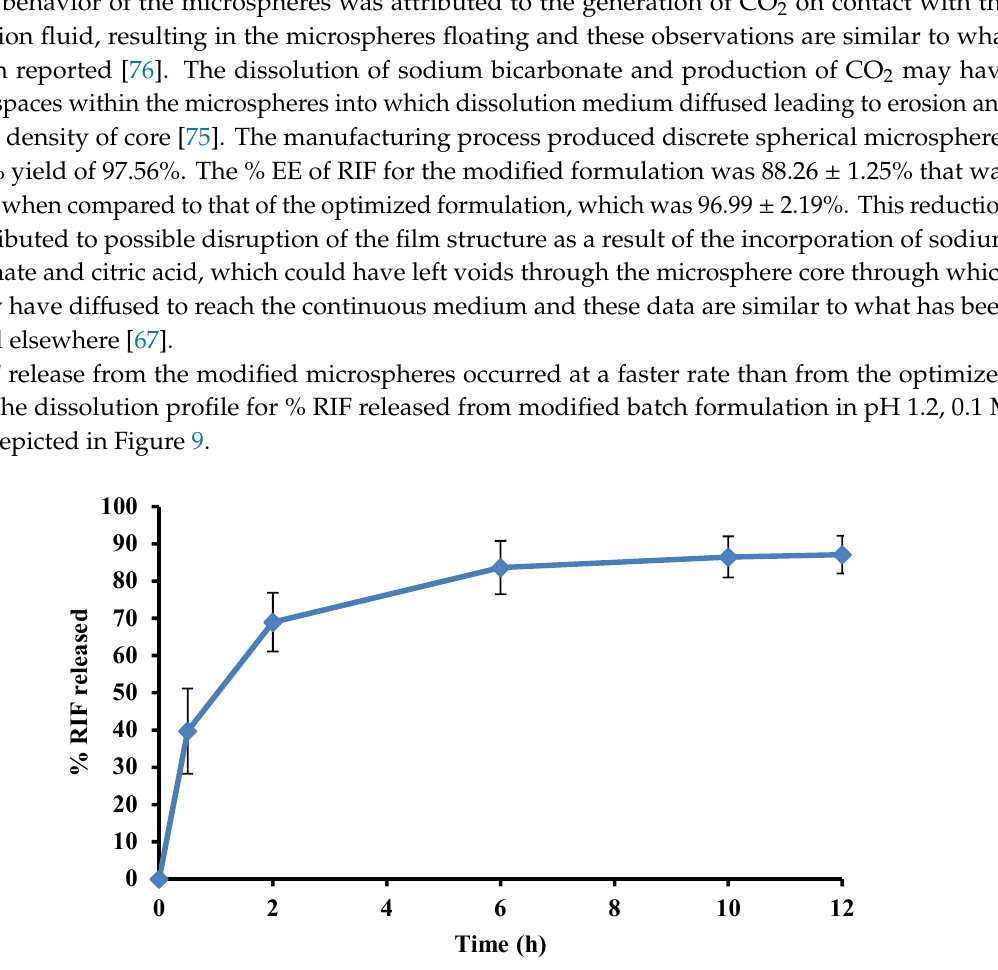
Figure 9. Dissolution profile depicting % RIF released from the modified formulation in pH 1.2 0.1 M HCl after 12 h.